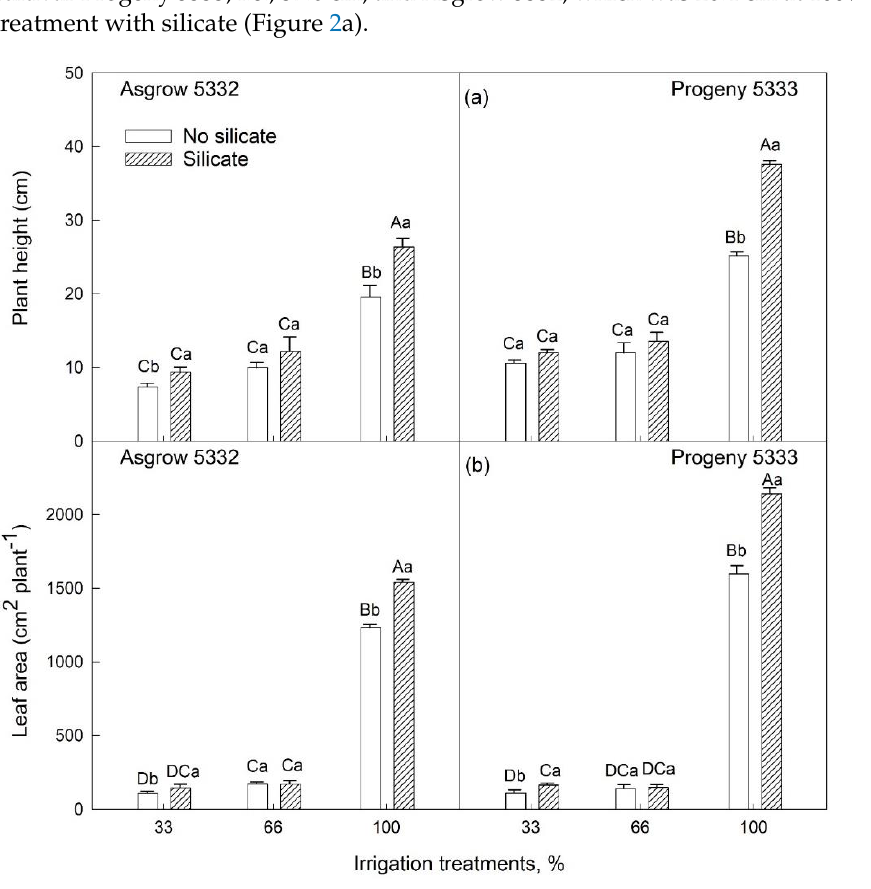
Figure 2. The influence of silicate application on soybean ( a ) plant height and ( b ) whole-plant leaf area across three irrigation treatments, measured at 27 days after emergence of the seedling. Three irrigation treatments (33%, 66%, or 100% of required water) were imposed on plants for 20 days. The values are mean and standard errors of five replications in each treatment. The error bars correspond to standard error. The bars followed by the same letters (lower-case letters within silicate and no silicate and upper-case letters within irrigation and silicate treatments) did not differ significantly at 5% by Tukey’s test.